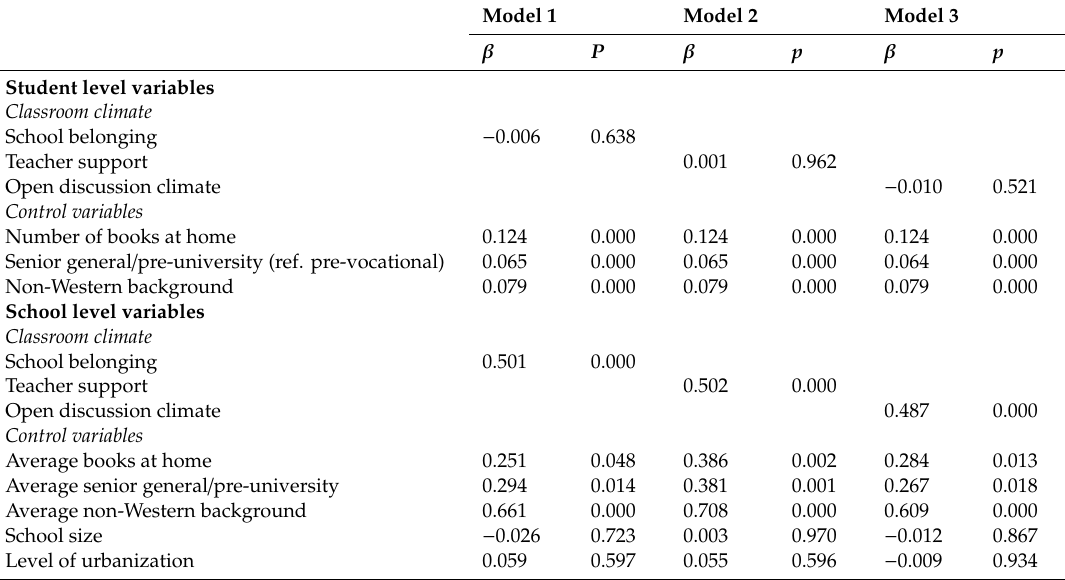
Table A7. Classroom climate e ff ects on citizenship attitudes (standardized